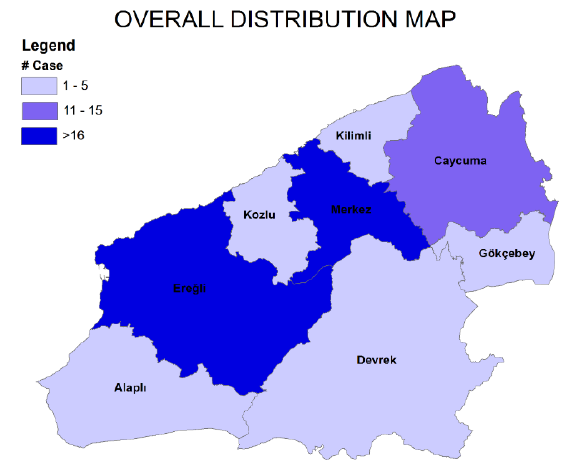
Figure 1. Overall distribution map of cancer cases When distribution maps of the children included in the study were examined based on their residence, it was seen that number of cancer cases in Kdz. Eregli and Center were the highest